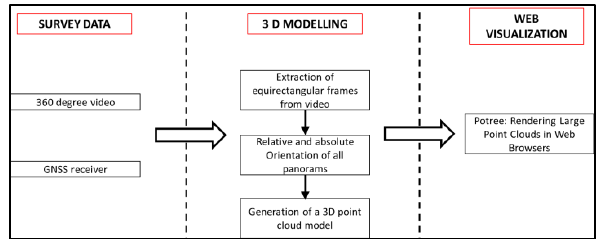
Figure 1. Workflow to display a point cloud in web tool from Spherical